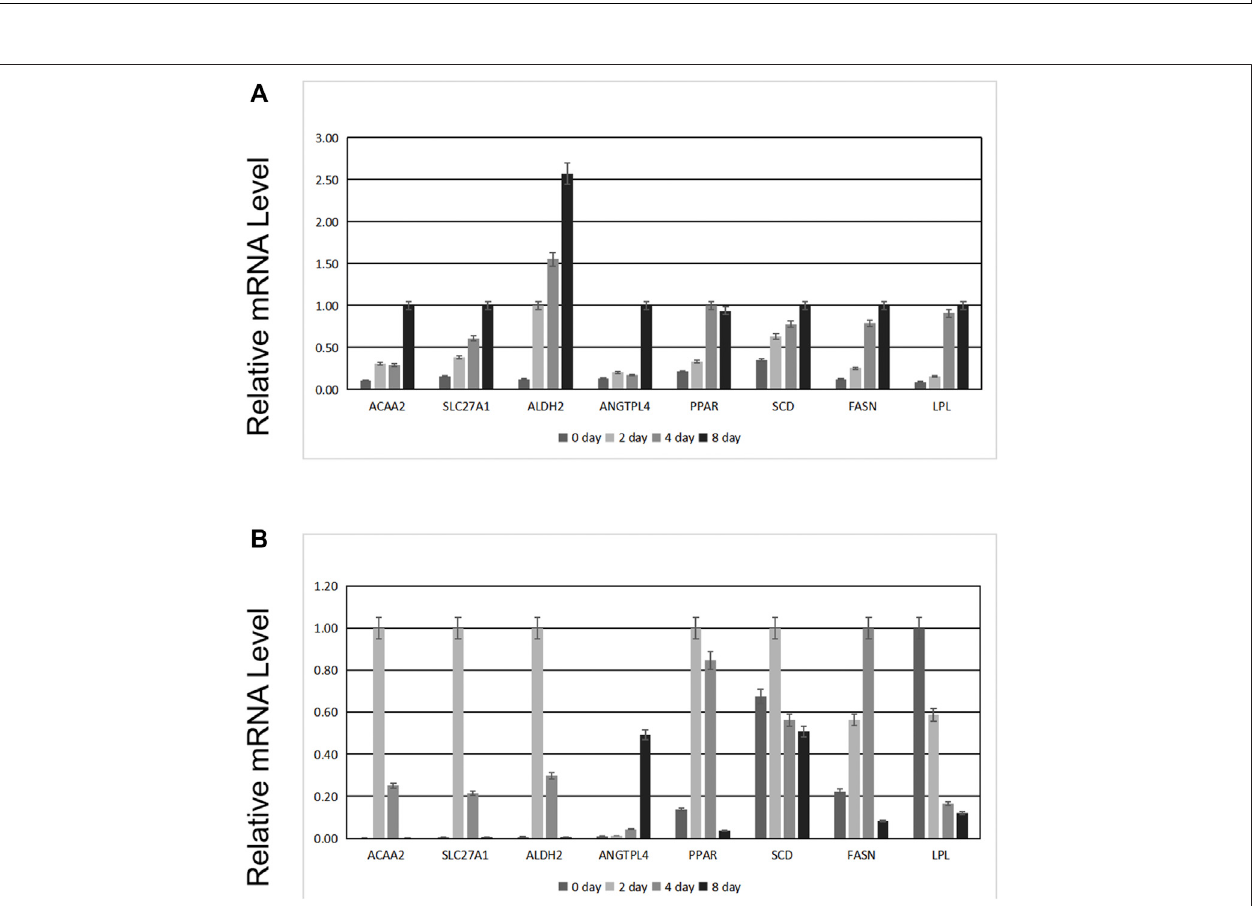
FIGURE7| Effectsof ANGPTL4 knockdownonthemRNAexpressionlevelsoftherelatedgenes. (A) ExpressionbeforetransfectionofsiRNA. (B) Expressionafter transfection of siRNA.